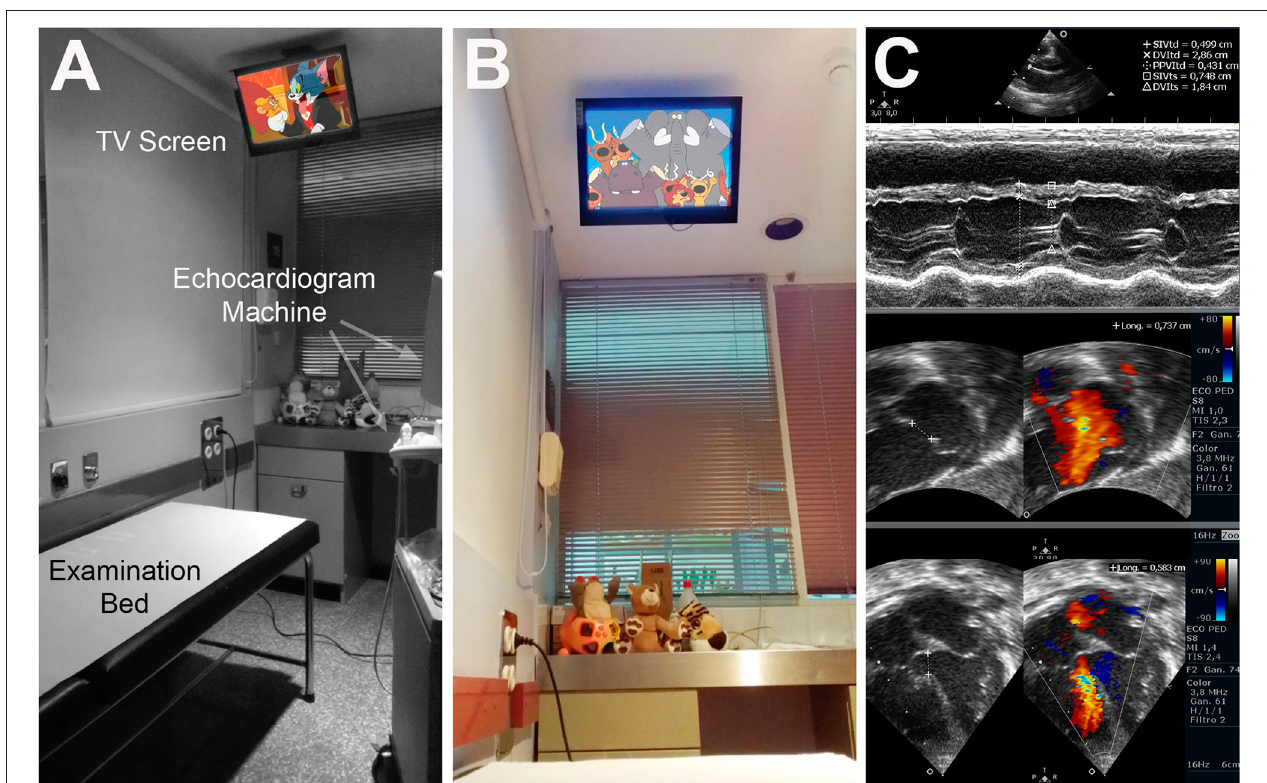
FIGURE 1 | Children’s examination room. (A) Detail of the examination bed and the TV screen on the ceiling. (B) Photograph from patient’s point of view. (C) Sample echocardiographs while the patient was watching